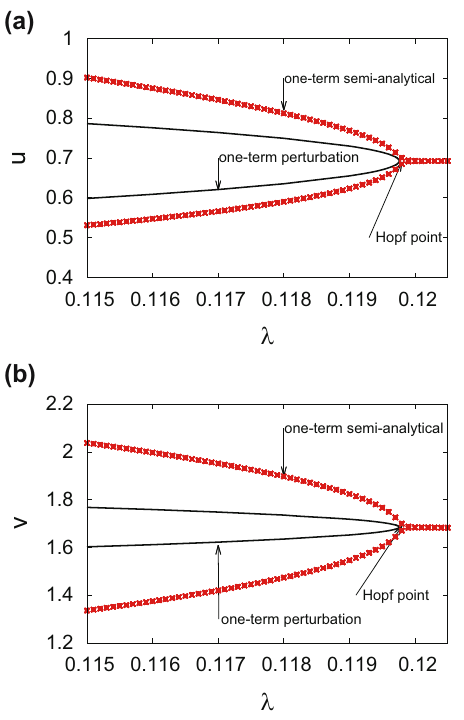
Figure 12: Bifurcation diagrams for ( a ) autocatalyst u and ( b ) reactant v concentrations, respectively, against bifurcation parameter λ . The one - term semi - analytical and perturbation results for the parameter values D